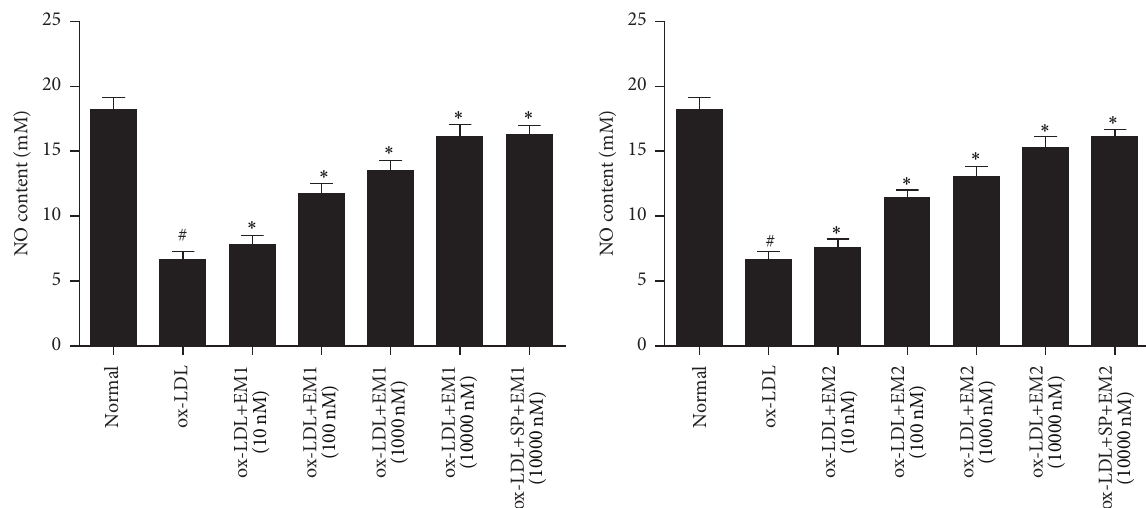
Figure 3: Effect of EM1/EM2 on production of NO of HUVECs treated by ox-LDL. All data is expressed as mean ± SD. ∗ 𝑃 < 0.05 versus control. # 𝑃 < 0.05 versus ox-LDL.